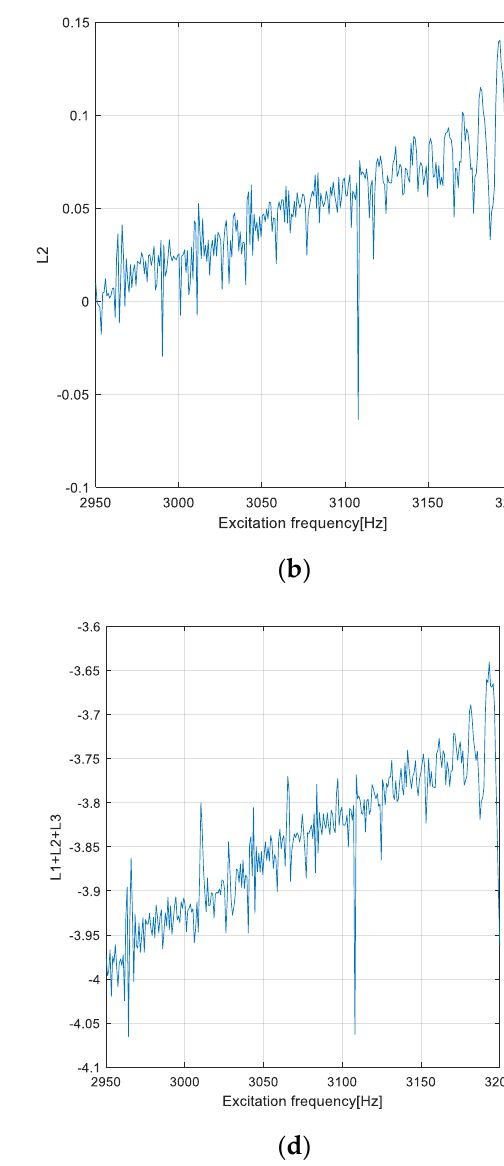
= 9 0 , ξ = 11.4 · 10 − 3 9  = , 3 11.4 10 −  =  . Figure 20. Lyapunov exponents of Nonstationary FTV for DIE1, β 1 1